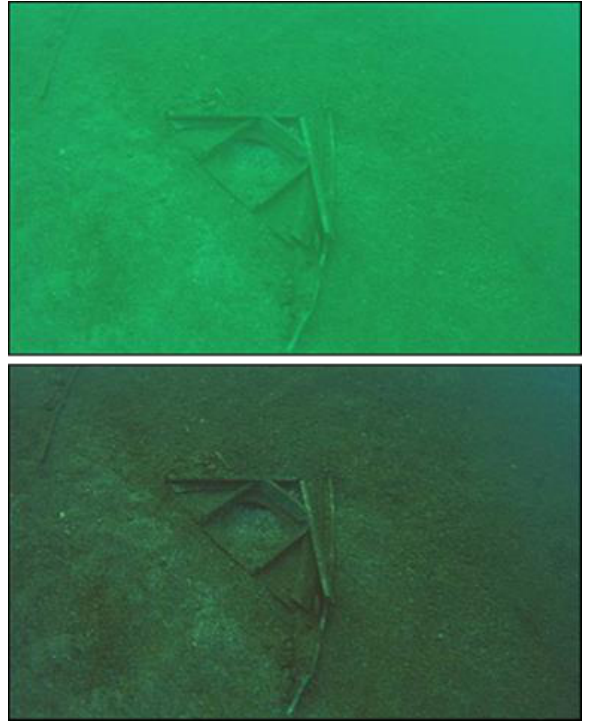
Figure 9. Before (above) and after (below) the application of the radiometric processing of the selected technique